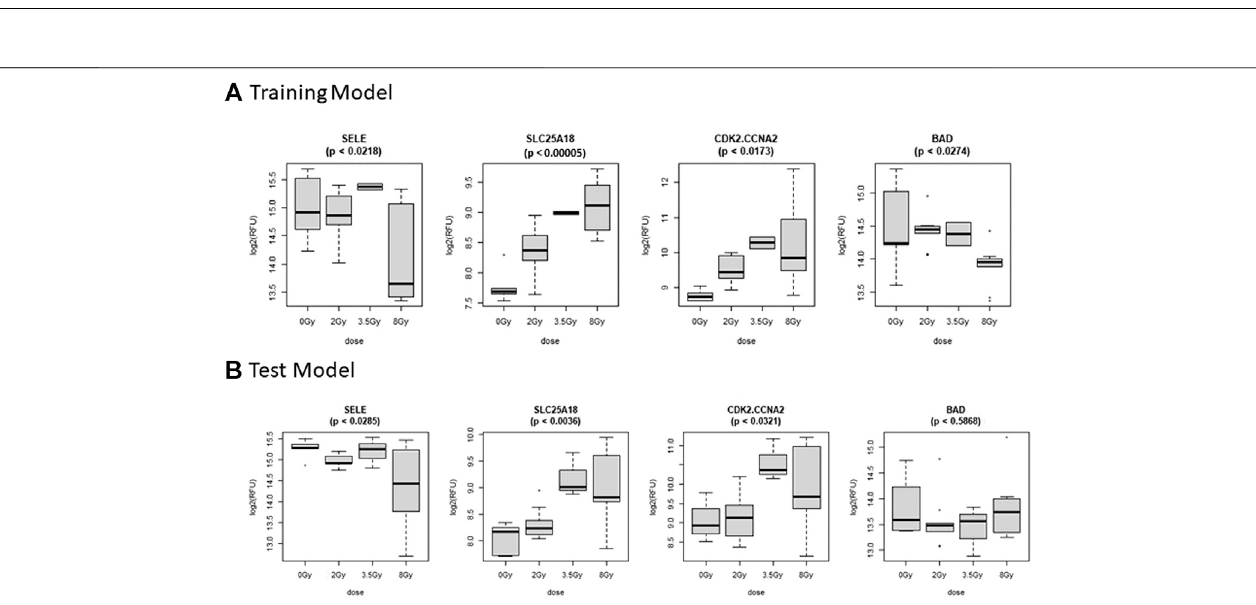
FIGURE 6 | Comparison of Selected Proteins in Control vs. Dose Model. Individual biomarker expression pro fi les for each Control vs. Dose Model protein are shown for the sample sets used for both the (A) Training and (B) Test models.